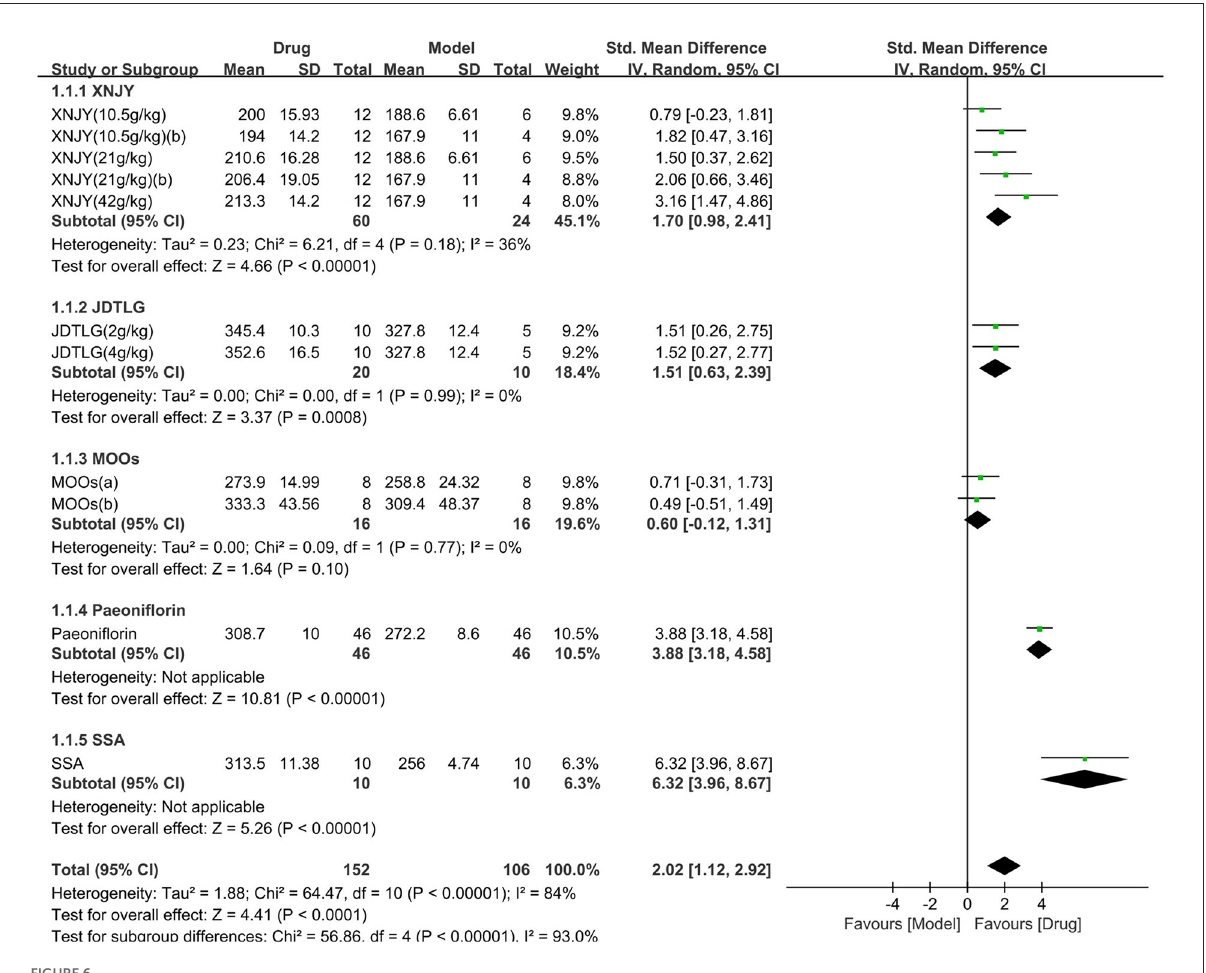
FIGURE6 Efficacy of CHM on body weight. Forest plots of the effect size calculated using SMDs. The horizontal error bars represent the 95% confidence interval of individual